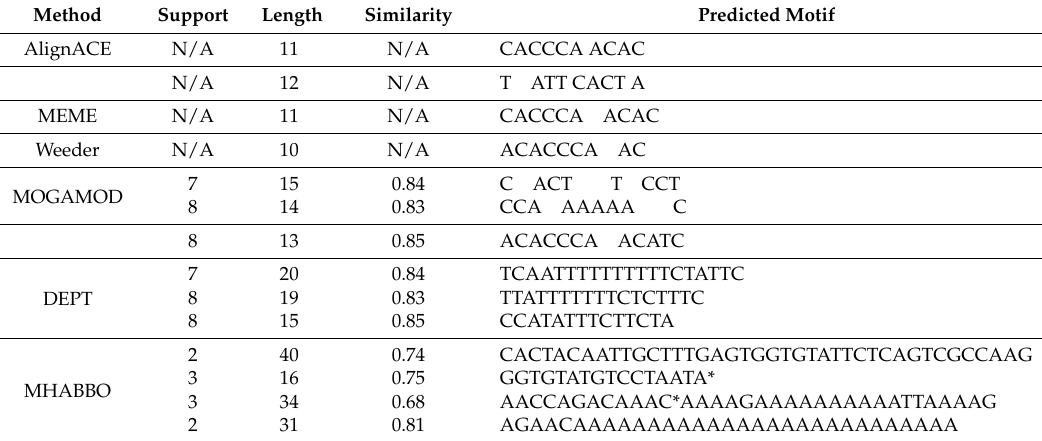
Table 6. Comparisons of the predicted motif with different methods for yst08r.